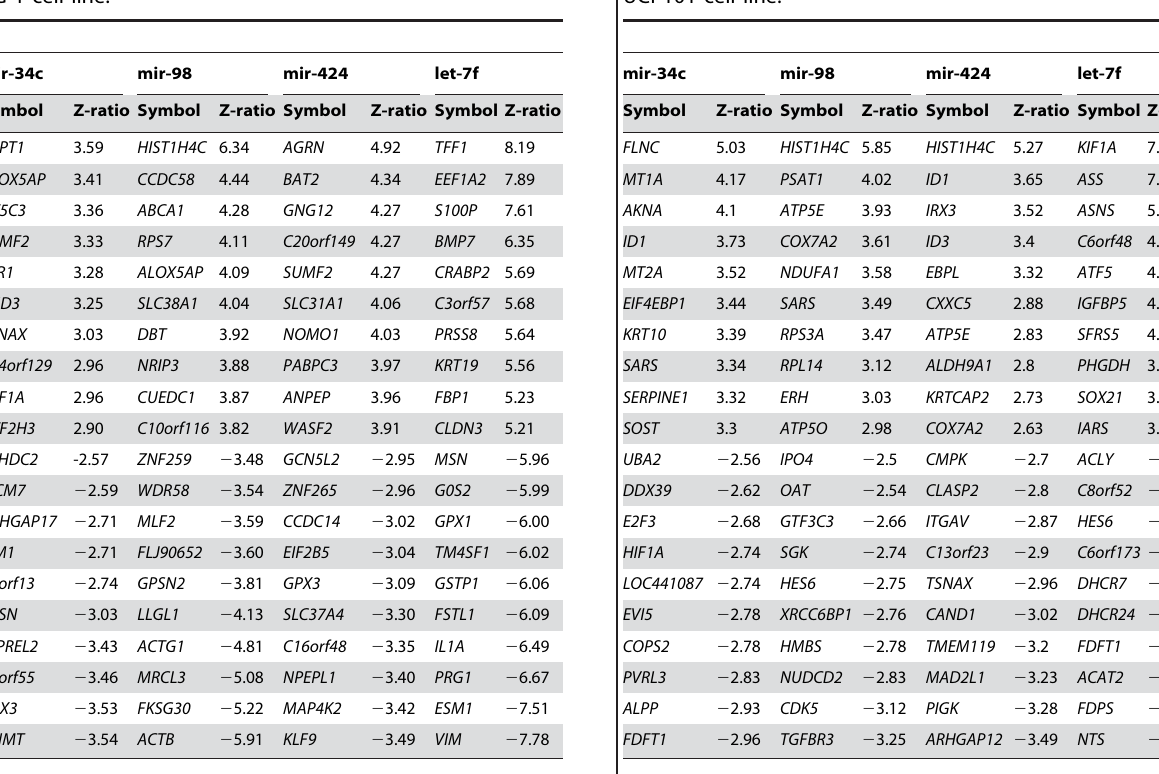
Table 3. Top 10 up-regulated and down regulated genes after over expression of mir-34c, mir-98, mir-424 and let-7f in BG-1 cell line.